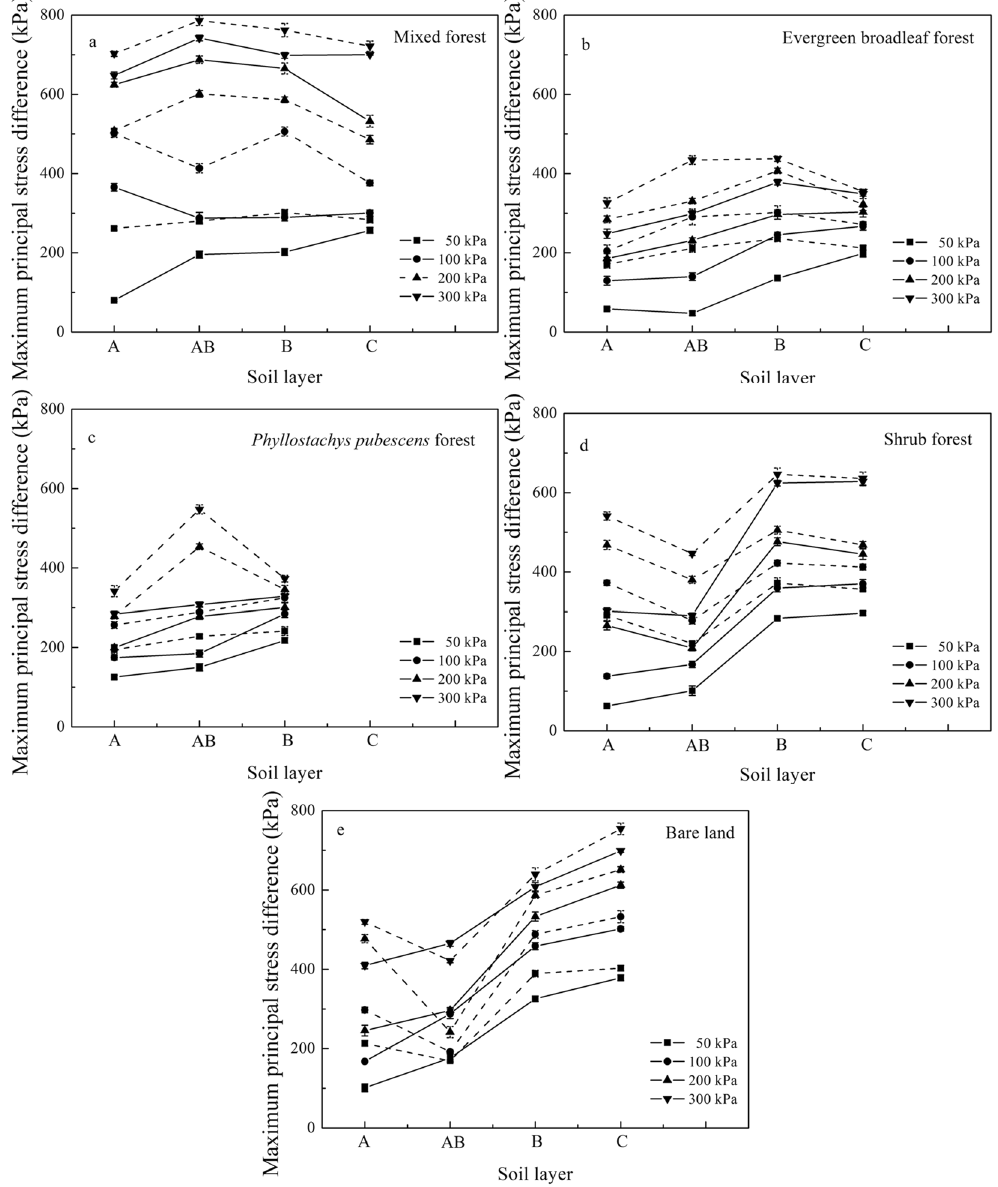
Figure 2. Variation of limit stress in soil layers under different confining pressures using the triaxial test. The solid line depicts the UU test on undisturbed soil and the dotted line depicts the UU test on remoulded soil. Error bars indicate the standard deviation (SD) of each